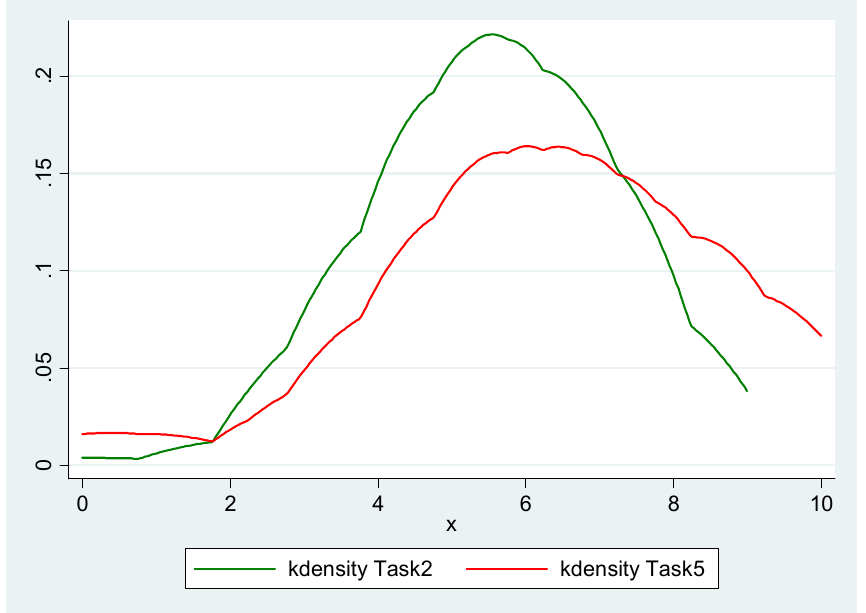
Figure A6. Kernel densities of the number of certain choices (i.e., switching points in the CvU tasks). Selected by the subjects, which represent the distributions of the degrees of risk aversion.